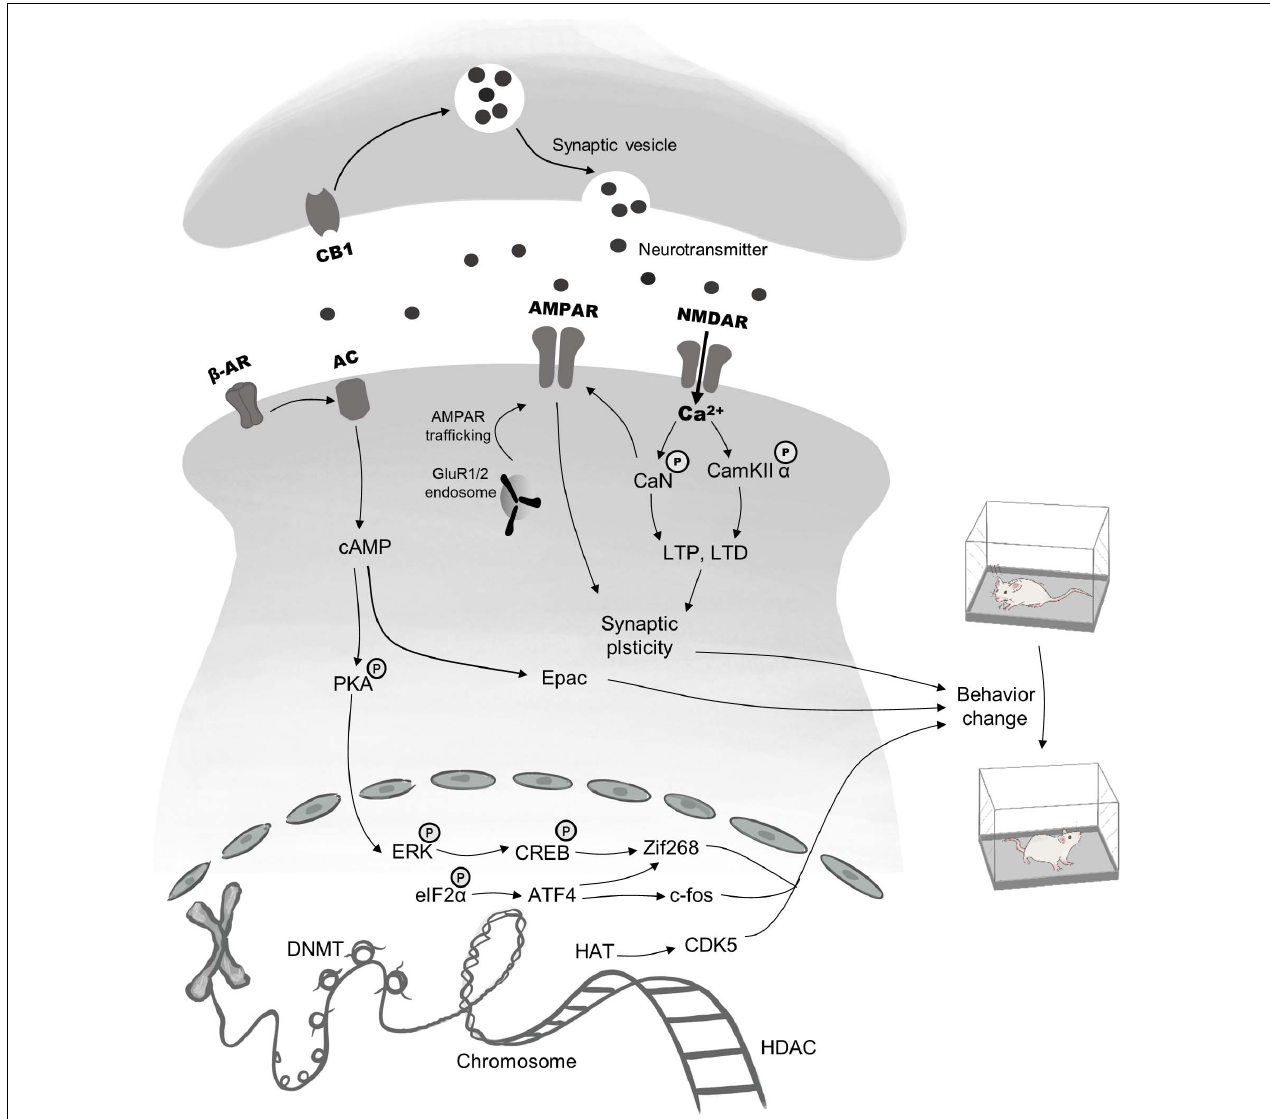
FIGURE 1 | Brief description of pharmacological targets and signaling cascades recruited in reconsolidation. The process of drug memory reconsolidation requires a complicated regulatory network, including epigenetic mechanisms, gene transcription, and activation of membrane receptors, all of which are responsible for behavior changes. Targets for epigenetic modifications mainly lie in the HAT, the HDAC, the DNMT. Besides, the phosphorylation and dephosphorylation of ERK and eIF2 α within the nucleus regulate the expression of immediate early genes, such as CREB, Zif 268, and c-fos, thus ultimately lead to changes in addiction behaviors. Finally, pre-and postsynaptic membrane receptors including AMPAR, NMDAR, β -AR, and CB1 have been proved to be effective targets. Main downstream mechanisms contain the second messenger (cAMP)-mediated pathway, AMPAR & NMDAR regulated synaptic plasticity and neurotransmitter transport.